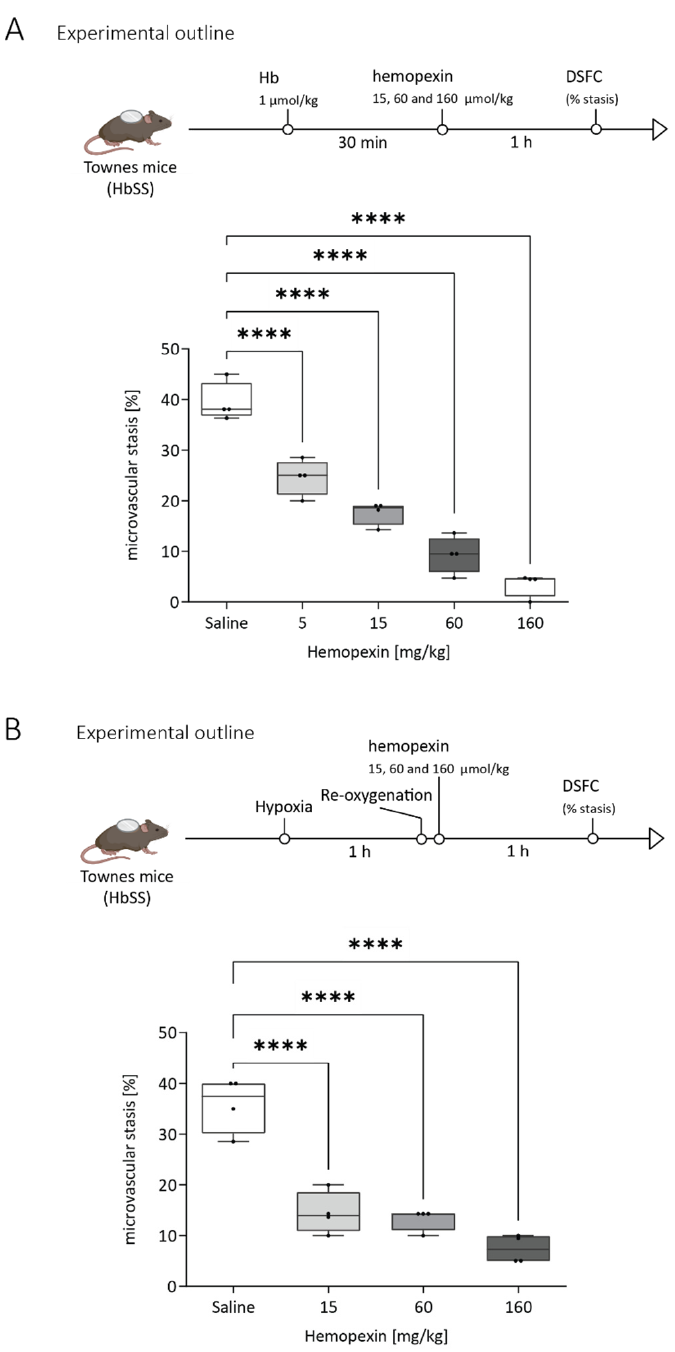
Figure 3. Hemopexin dose-dependent decrease in stasis after hemoglobin or hypoxic challenge. ( A ) Therapeutical experimental setup: Dorsal skin-fold chambers were implanted onto Townes HbSS mice and 20–24 flowing venules were selected in each HbSS mouse at baseline (time 0). Microvascular stasis was induced by hemoglobin (1 µ mol/kg) infusion. Thirty minutes after the Hb challenge, animals were infused with hemopexin (5, 15, 60 or 160 mg/kg) or saline vehicle. Microvascular stasis (% non-flowing venules) was measured in the same venules 1 h after hemopexin infusion ( n = 4/dose) ( B ) Therapeutical experimental setup: similar to ( A ) except that microvascular stasis was induced by hypoxia-reoxygenation (H/R, 7% O 2 /93% N 2 ) for 1 h followed by room air for 5 min with subsequent infusion of hemopexin (15, 60 or 160 mg/kg) or saline. Microvascular stasis (% non-flowing venules) was measured in the same venules 1 h after hemopexin infusion ( n = 4/dose). Box and whiskers plots represent means ± Min to Max. **** p < 0.0001 versus SS (saline treated). ns = not